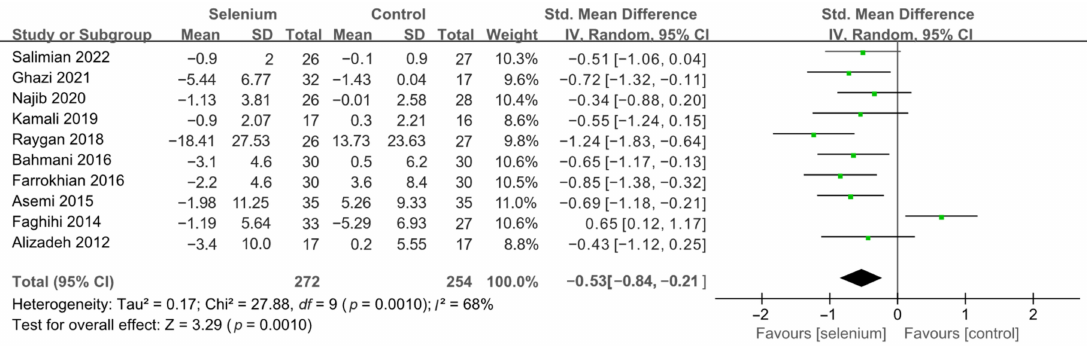
Figure 3. Risks of bias graph expressed as percentages.